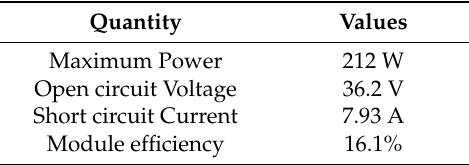
Figure 1. Map of possible installation of photovoltaic power plant in a part of Naples’ tramway. Yellow circle one shelter, green circle two shelters. Table 1. Electrical data of photovoltaic panels.